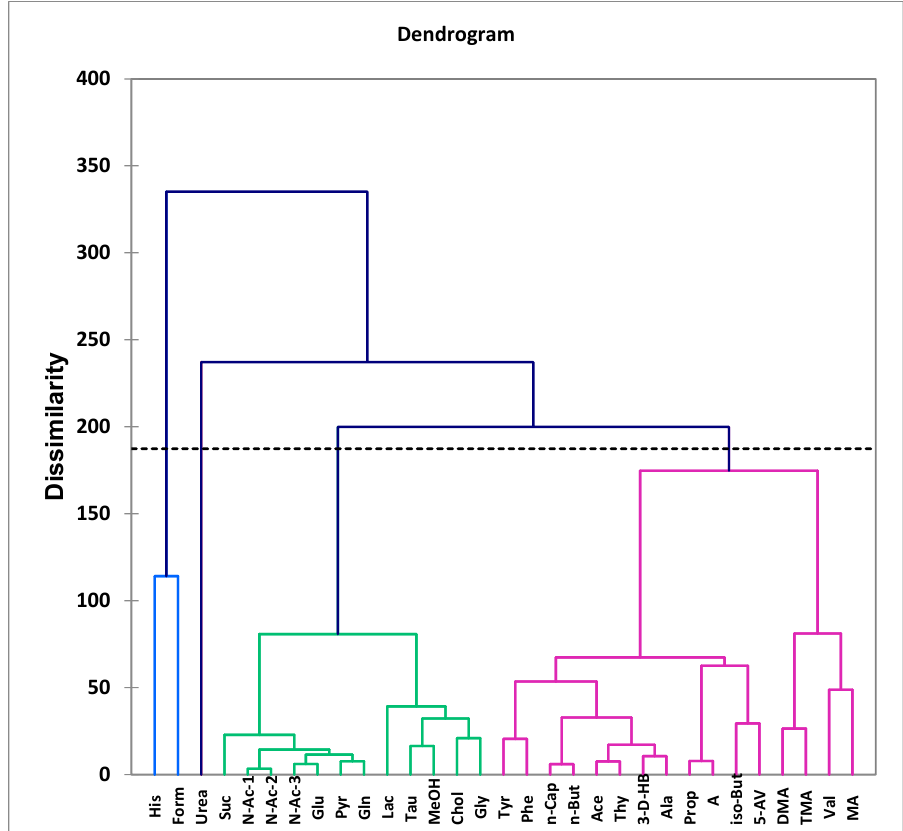
Figure 11. Agglomerative hierarchical clustering (AHC) analysis of metabolite variables of a healthy control WMS supernatant dataset showing the clear distinction of these into four separate clusters from the dissimilarity threshold index (dotted horizontal line), which are colored blue, black, green, and violet. The two larger green and violet clusters are further split into two sub-clus- ters, and one for the latter contains all bacterial-derived malodorous methylamine species with the amino acid valine (far right-hand side), whilst the other contains all oral microbiome-derived or- ganic acid anions, specifically n -caproate, n -butyrate, iso -butyrate, propionate, 5-aminovalerate, and acetate, plus acetoin and the amino acids alanine, phenylalanine, and tyrosine. TSP-normalized me- tabolite levels were glog-transformed and Pareto-scaled prior to AHC analysis, which was con- ducted using Ward’s agglomeration method and Euclidean distance as a dissimilarity measure. Ab- breviations: As Figure 10. An AHC model developed for the investigation of predictor metabolite clusterings or pools in this healthy control WMS supernatant dataset was largely very consistent with that obtained from factor analysis loadings vectors (Figure 11). Indeed, four major clusters were found, and from right-to-left. These comprise (1) oral microbiome-sourced biomole- cules, specifically all organic acid anions (n-caproate, n-butyrate, iso-butyrate, propionate, acetate and 5-aminovalerate), malodorous methylamines (MA, DMA, and TMA), 3-D-hy- droxybutyrate, acetoin, and thymine, along with the amino acids valine, alanine, phenyl- alanine, and tyrosine, which potentially arise from the actions of proteolytic bacteria (phe- nylalanine and tyrosine are presumably sub-clustered together since the latter arises from oxidation of the former)—all malodorous methylamine species were sub-clustered with the amino acid valine away from all other bacterially derived catabolites; (2) host-derived metabolites, i.e., the amino acids glycine, taurine, glutamine, glutamate, all N-acetylated biomolecule derivatives, plus choline, lactate, pyruvate, and succinate; (3) urea alone, in view of its poor loadings on PCs1-4 above in factor analysis, and poor correlations with